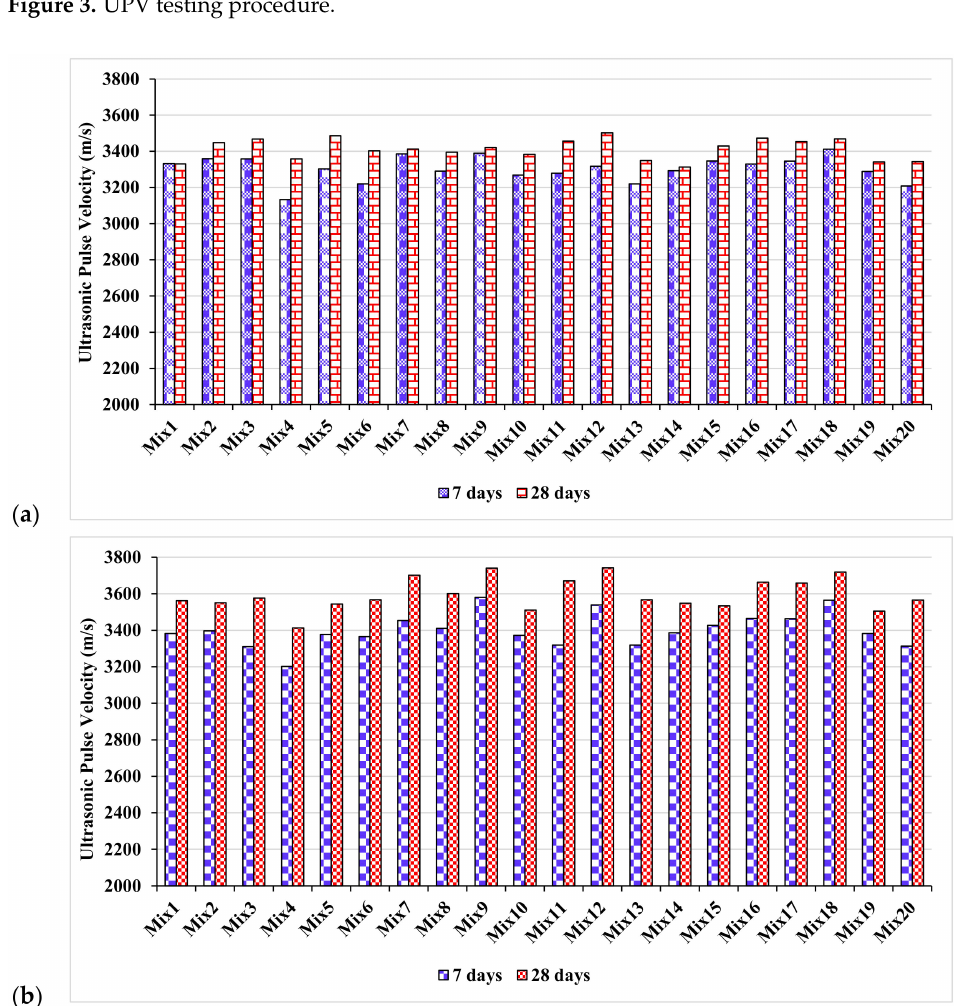
Figure 4. Experimental ultrasonic pulse velocity of mixes: ( a ) control; and ( b ) waste marble